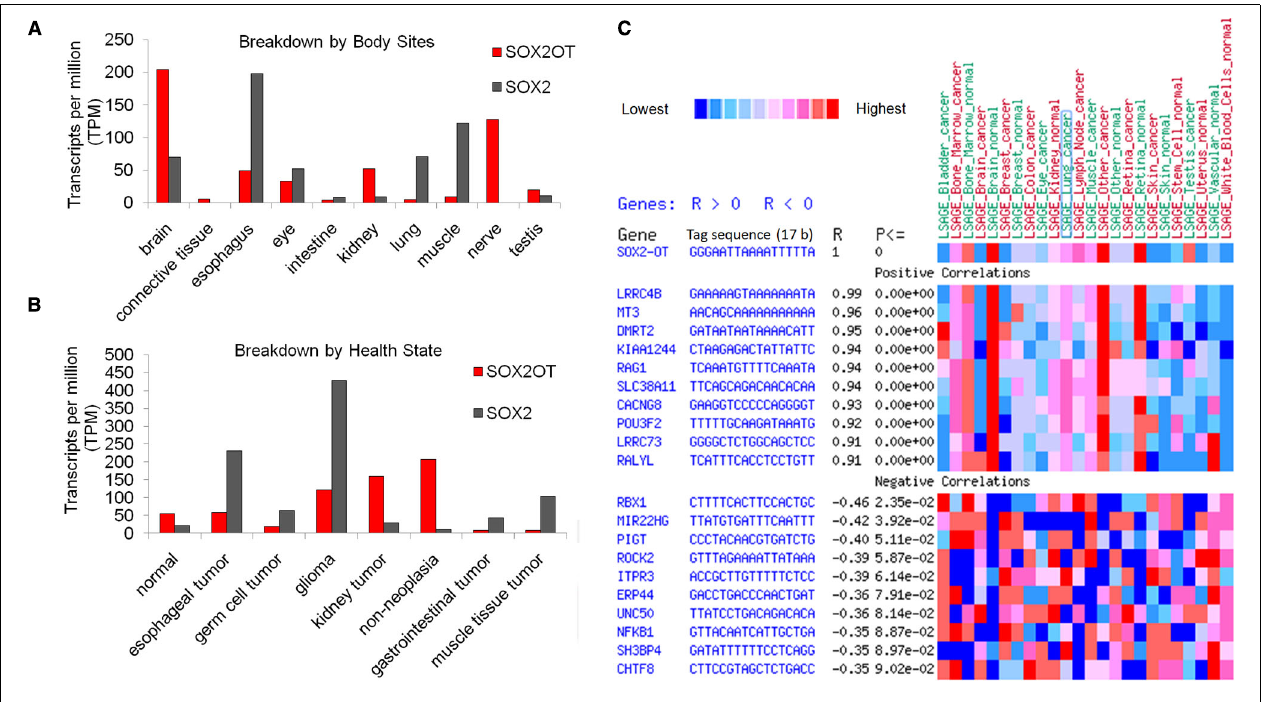
FIGURE 4 | Expression signature of SOX2OT and its correlations with other genes in human. (A,B) Approximate expression profiles of SOX2OT and SOX2 based on ESTs (dbEST) distribution in human tissues, and tumors libraries; the data is presented according to TPM (transcript per million) in pool. High enrichment of SOX2OT expression in CNS libraries and also brain-derived tumors is noticeable. (C) Two dimensional display of gene expression summary of SOX2OT SAGE expression represents